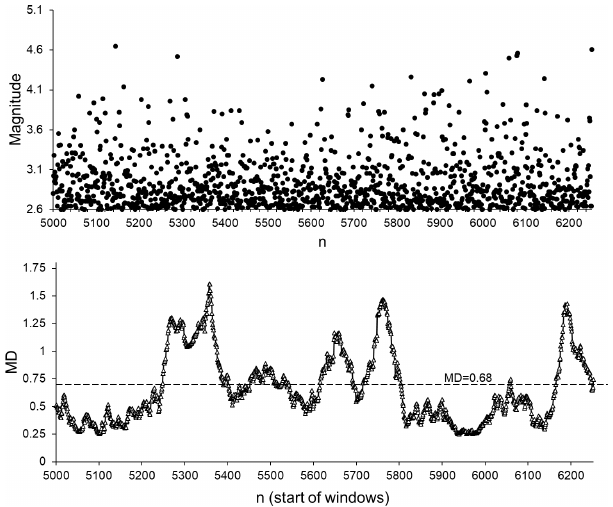
Figure 13. Magnitudes and MD values calculated for the non- aftershock part of the SC catalogue from 7 March 1983 (sequential number in SC catalogue 5000) to 5 February 1985 (sequential num- ber in SC catalogue 6253). Average MD values are calculated for 50-data windows shifted by one data step.